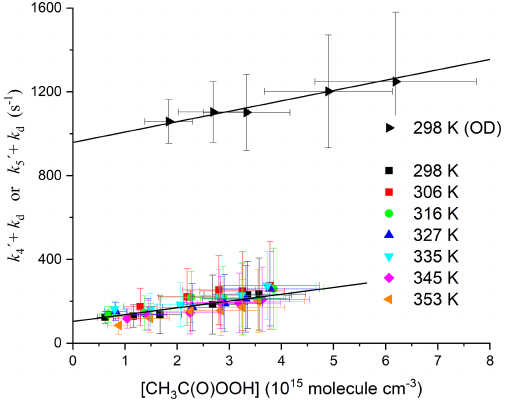
Figure 6. Pseudo-first-order rate coefficient for the loss of OH ( k (cid:48) or OD ( k (cid:48) ) (after subtraction of the contribution of CH 3 C(O)OH) 5 versus [CH 3 C(O)OOH]. The slopes of the solid black lines are k 4 (lower dataset, with intercept ∼ 100s − 1 ) and k 5 (uppermost dataset with intercept ∼ 900s − 1 ). The larger intercept for the OD reaction is due to the reaction with DONO 2